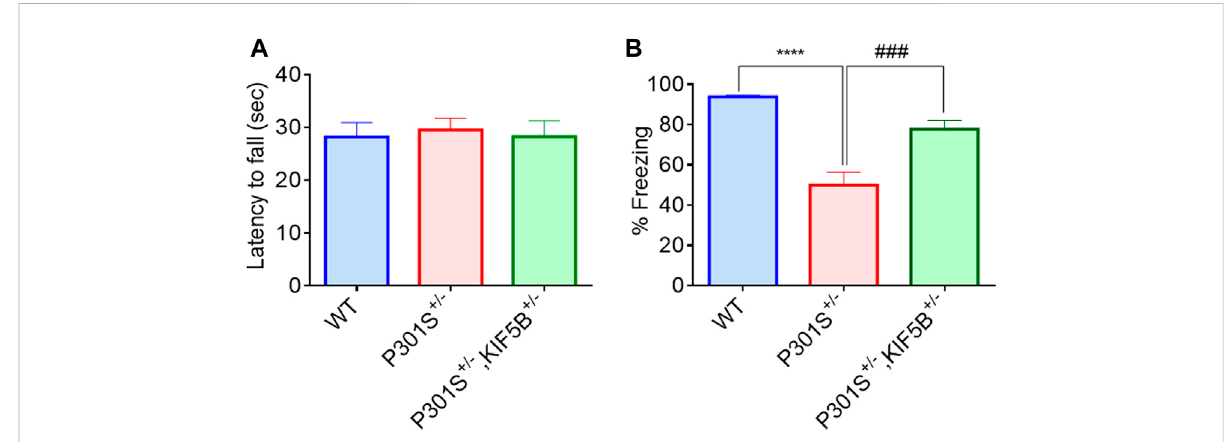
FIGURE 6 De fi ciency of KIF5B ameliorated hippocampal and amygdala-dependent memory de fi cit in P301S tau mice without in fl uencing their motor function. (A) In the rotarod test, the average latency of fall was calculated for WT, P301S+/ − and P301S+/ − ,KIF5B+/ − mice at 8 -months old (n = 11 − 15), and none of the groups show motor dysfunction. (B) In the Contextual fear conditioning test, the mean % freezing was quanti fi ed in each group and data were presented in mean +SEM. ****p < 0.0001 vs. WT mice, ###p < 0.001 vs. P301S+/ − mice, analyzed by one-way ANOVA with post hoc Tukey ’ s Multiple comparison